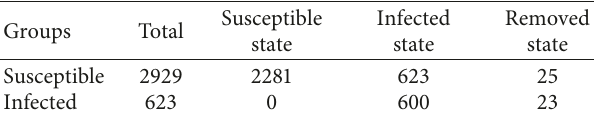
Table 4: Number of individuals at any state for HB at the end of the period.